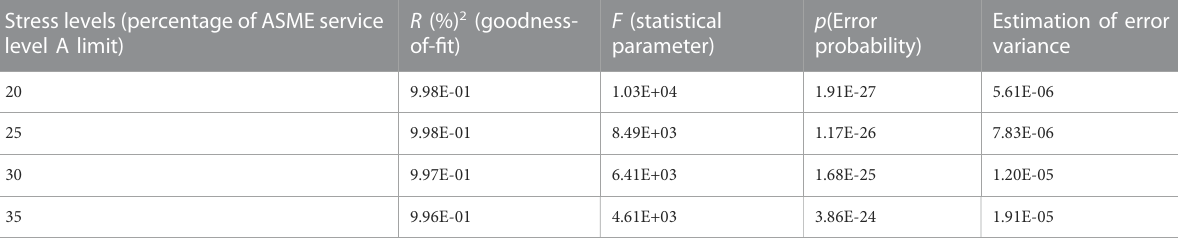
TABLE 5 Linear fi tting results of the CTWC axial displacement in thin-walled pipes. Stress levels (percentage of ASME service level A